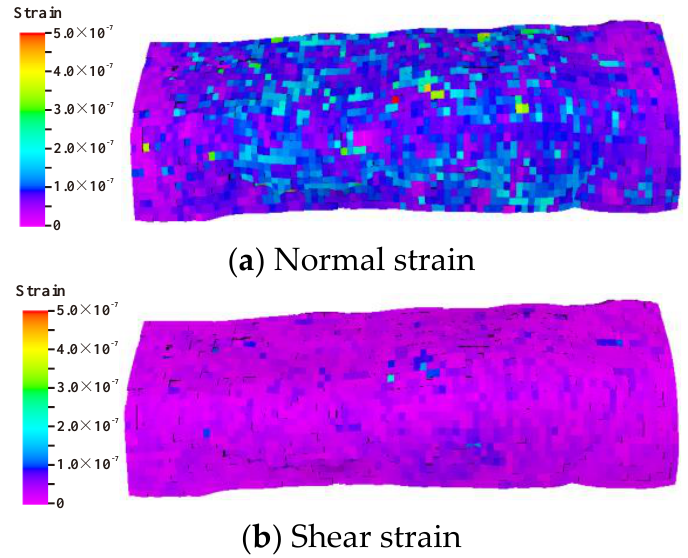
Figure 14. Elastic strain distribution of natural fractures in the target formation.